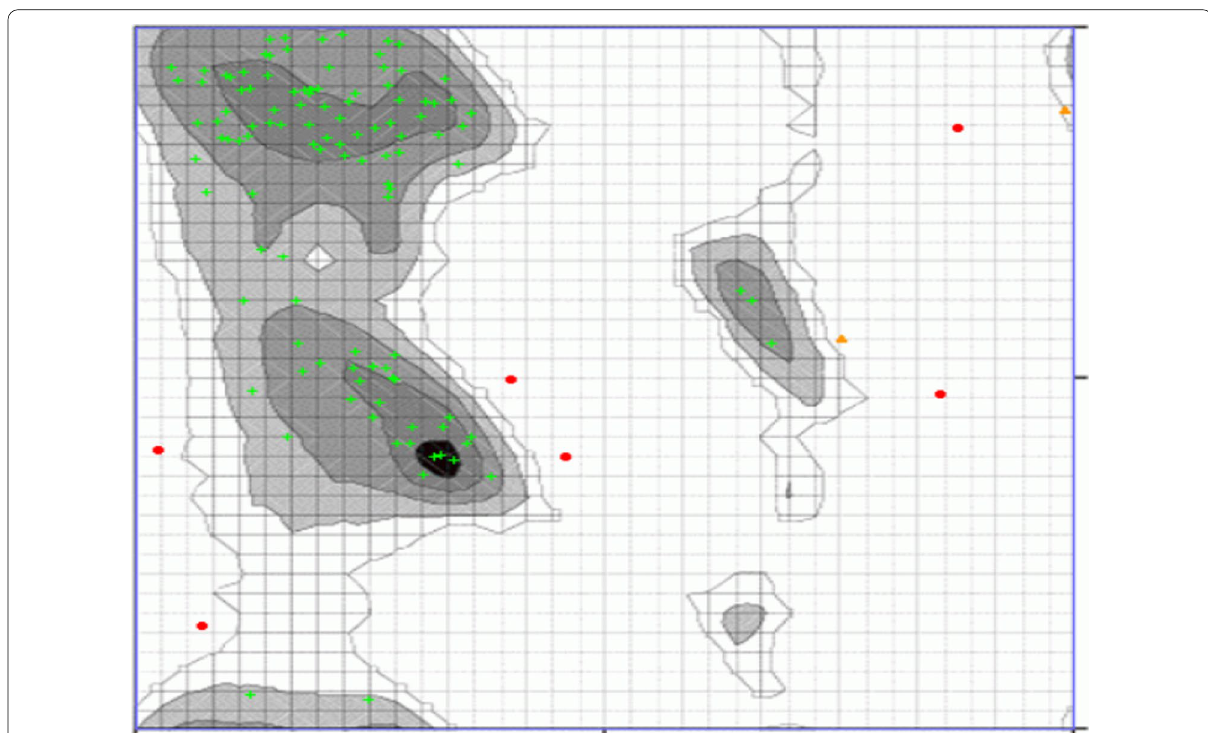
Fig. 8 G. mellonella SOD protein structure by Ramachandran plot with 93% of amino acids (https:// zlab. umass med.